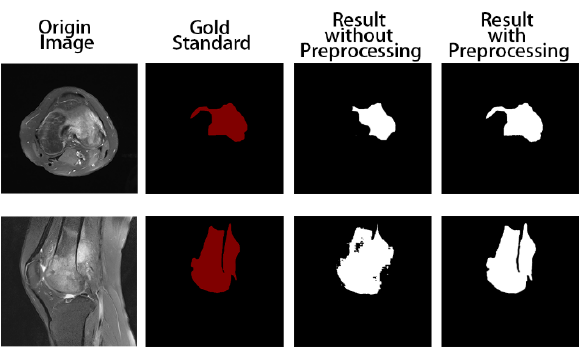
Figure 5. Comparison of segmentation results of the model with and without data preprocessing.